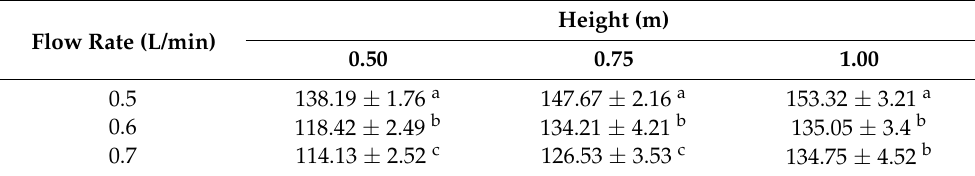
Table 4. Effect of the flow rates on VMD ( µ m).